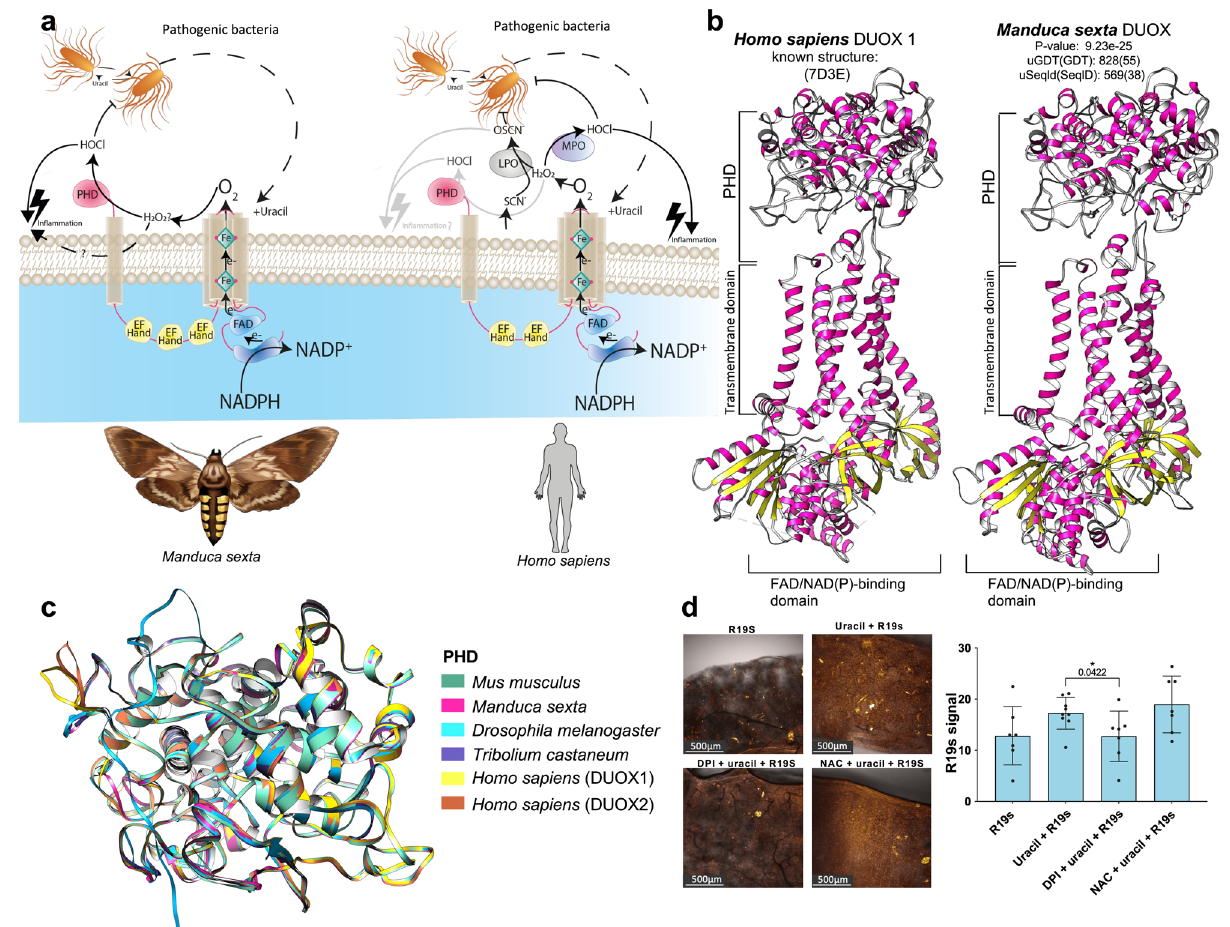
Fig. 6 | Conservation of human and M. sexta DUOX and HOCl production. a Comparative structures of DUOX in M. sexta and Homo sapiens (DUOX2). b Homologymodelingof M.sexta DUOX.Theknownstructureof H.sapiens DUOX1 (left) and model-assisted protein binding site prediction of M. sexta DUOX (right). Regions that were not modeled in the human DUOX1 template structure are also not shown in the model of M. sexta DUOX. c The peroxidase homology domain (PHD)istheactivesiteofHOClproductionandispredictedtobehighlyconserved